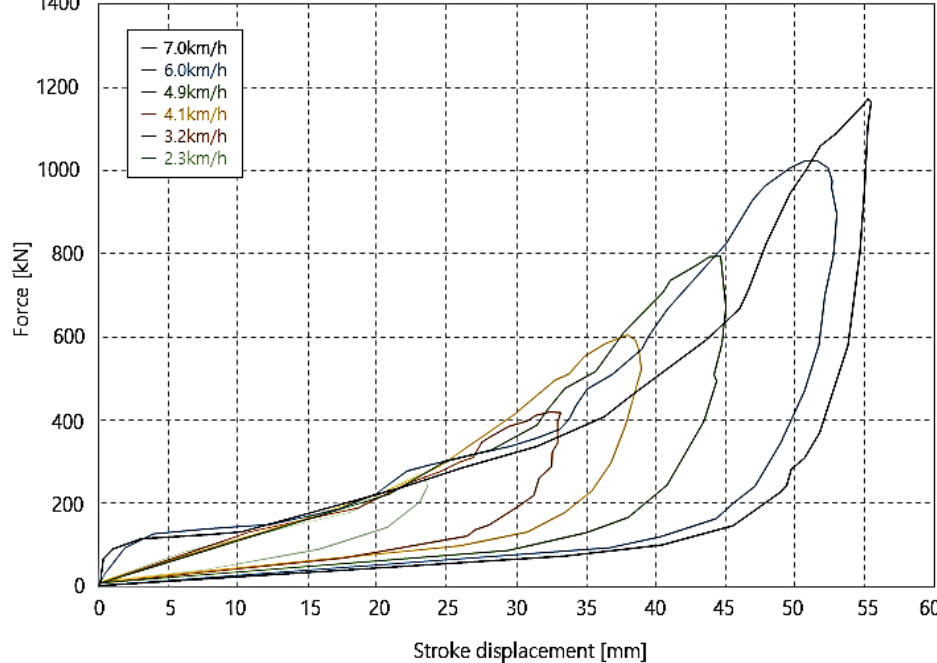
Figure 12. Characteristic curve of rubber buffer in collision test.